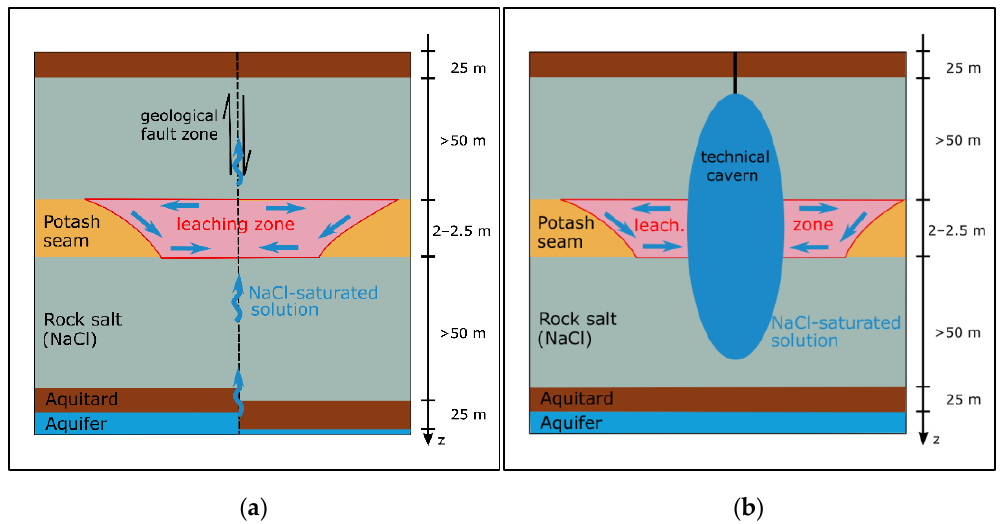
Figure 1. Sketch of leaching zones ( a ) in salt mining (symmetrical in x- and y-direction) and ( b ) in the construction of technical caverns (radially symmetrical).